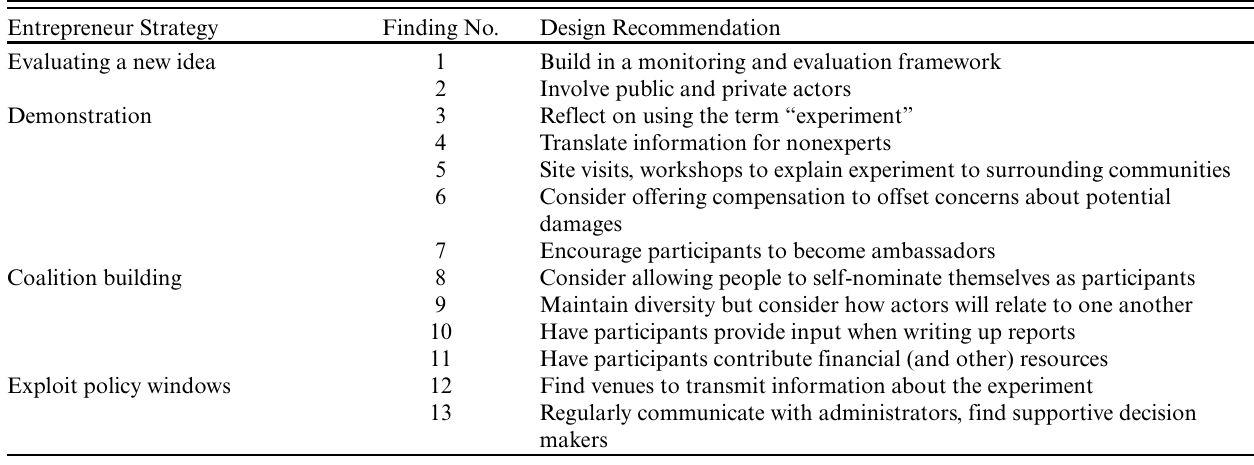
Table 2 . Findings on role of experiments in policy change strategies: suggestions based on Dutch water management experiences. Entrepreneur